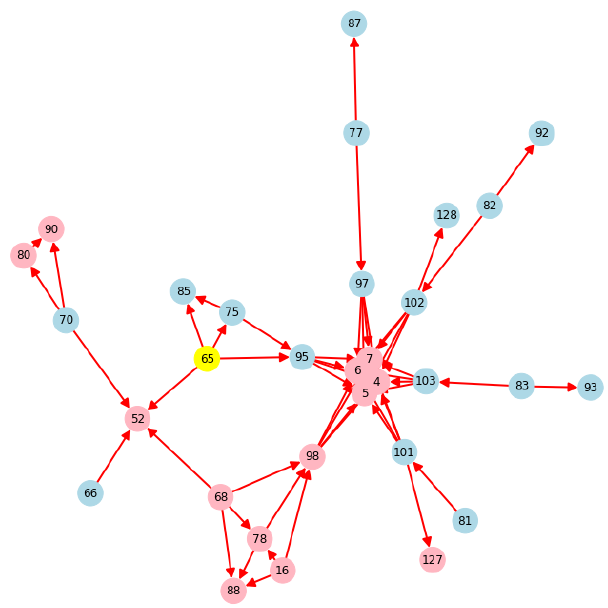
Figure 20. The fault propagation path when t = 710 min in Mode 4 (yellow: root cause; red: rise or step up; blue: fall or step down).